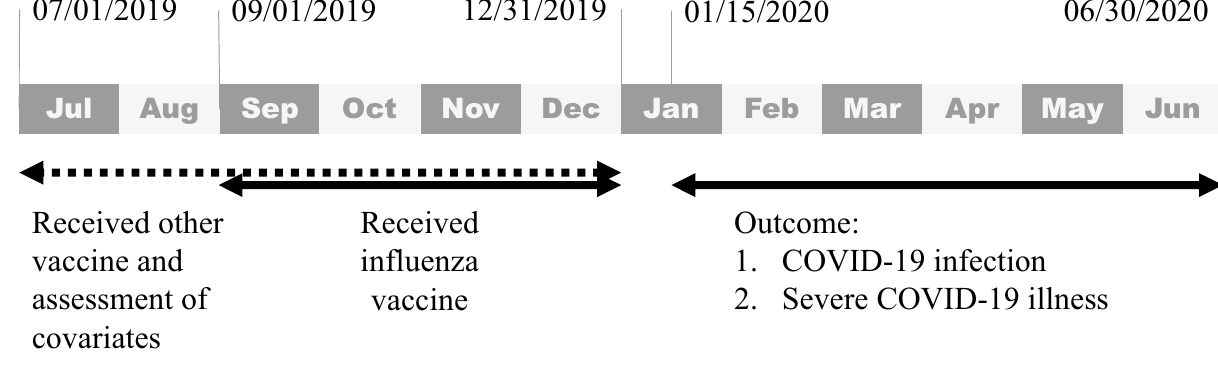
Figure 1. Timeline of covariate assessment, receipt of influenza or other vaccine, and